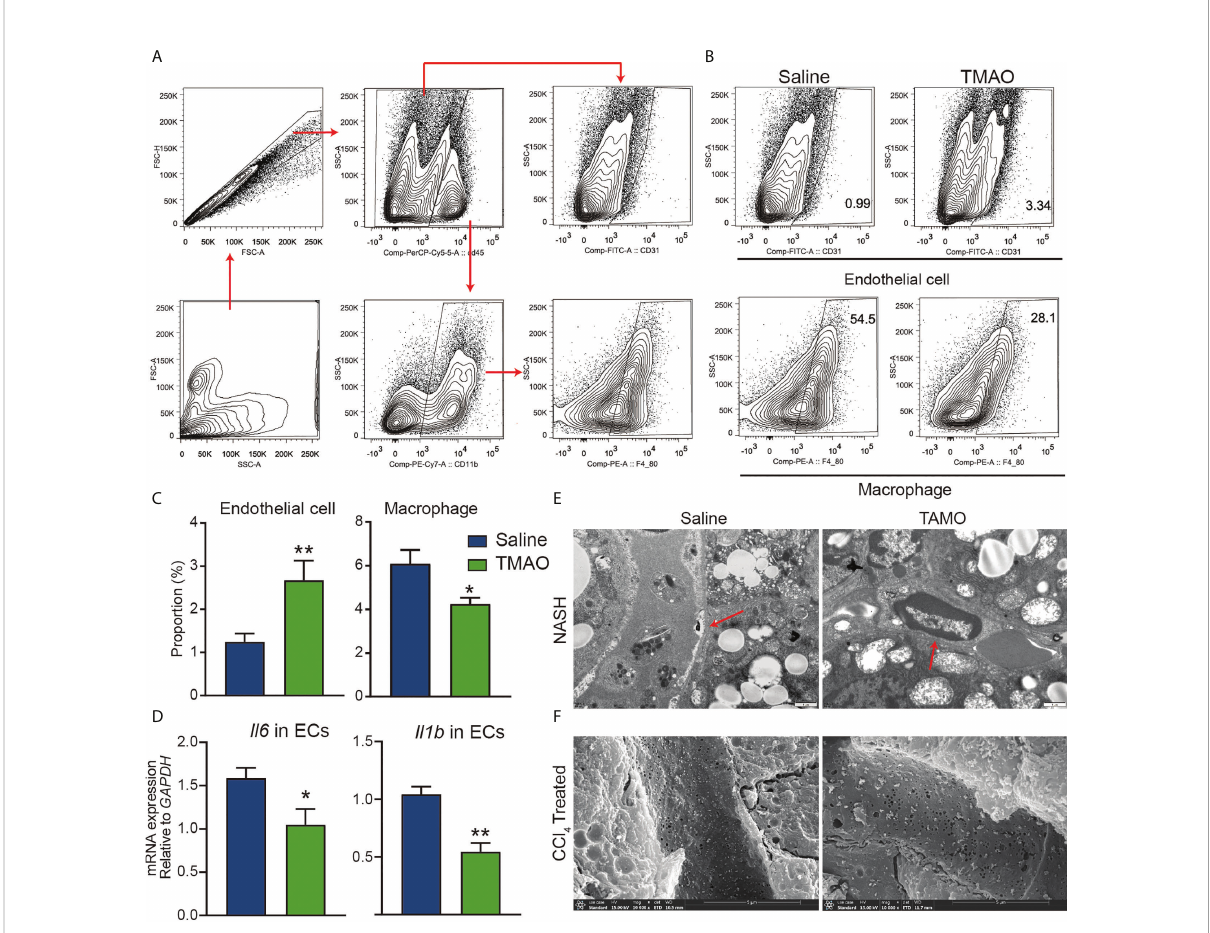
FIGURE 4 TMAO protects the integrity of vascular endothelial cells (A – C) Representative fl ow cytometry data of endothelial, macrophages and neutrophil cells in liver nonparenchymal cells (NPCs). (D) mRNA levels of IL-6 and IL-1 b in endothelial cells of the liver. (E) Basement membrane (red arrows) changes were detected by TEM. (F) Fenestrations changes were detected by SEM. *p<0.05,